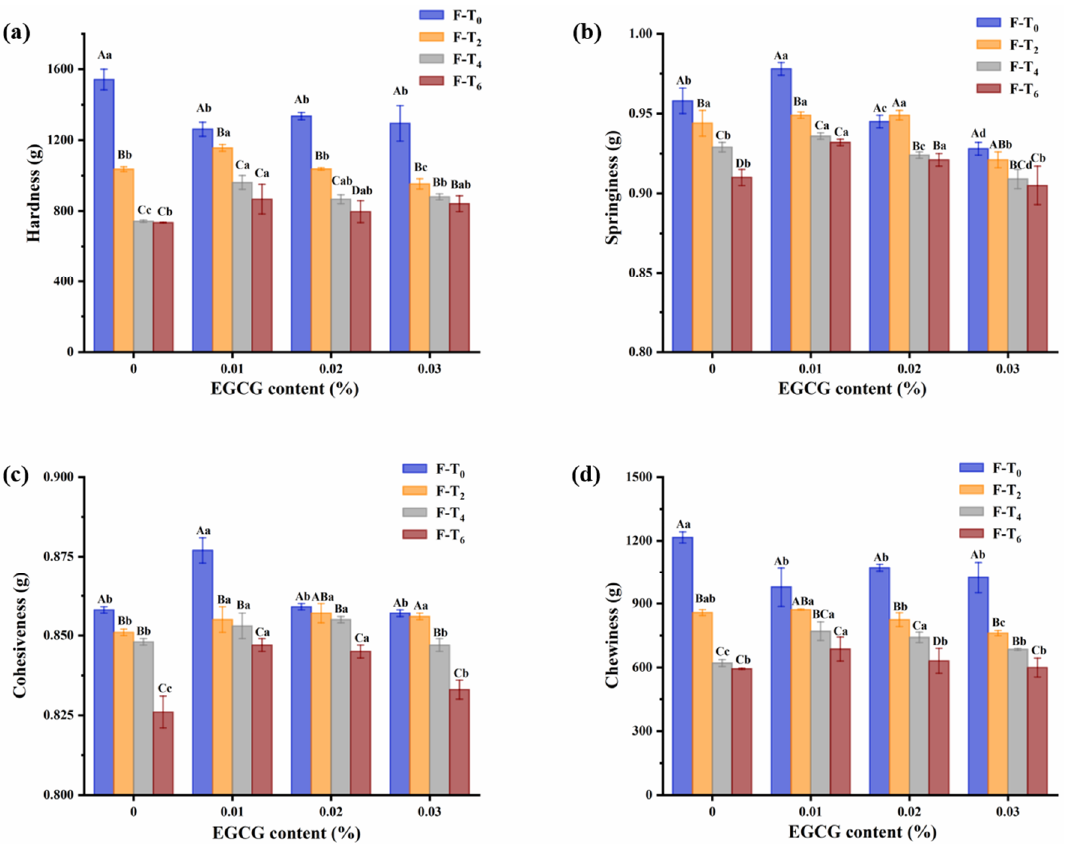
Figure 1. Changes in hardness ( a ), springiness ( b ), cohesiveness ( c ), and chewiness ( d ) of surimi gels treated with different content EGCG during F-T cycles. Uppercase letters indicate significant difference ( p < 0.05) between different F-T cycle, lowercase letters indicate the difference between gels with different EGCG content ( p < 0.05). F-T 0 : the zeroth freeze-thaw cycle; F-T 2 : the second freeze-thaw cycle; F-T 4 : the fourth freeze-thaw cycle; F-T 6 : the sixth freeze-thaw